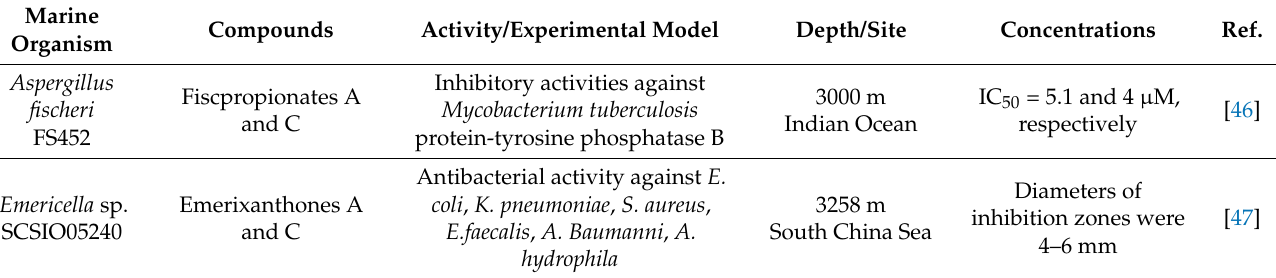
Table 2. Bioactive compounds from deep-sea